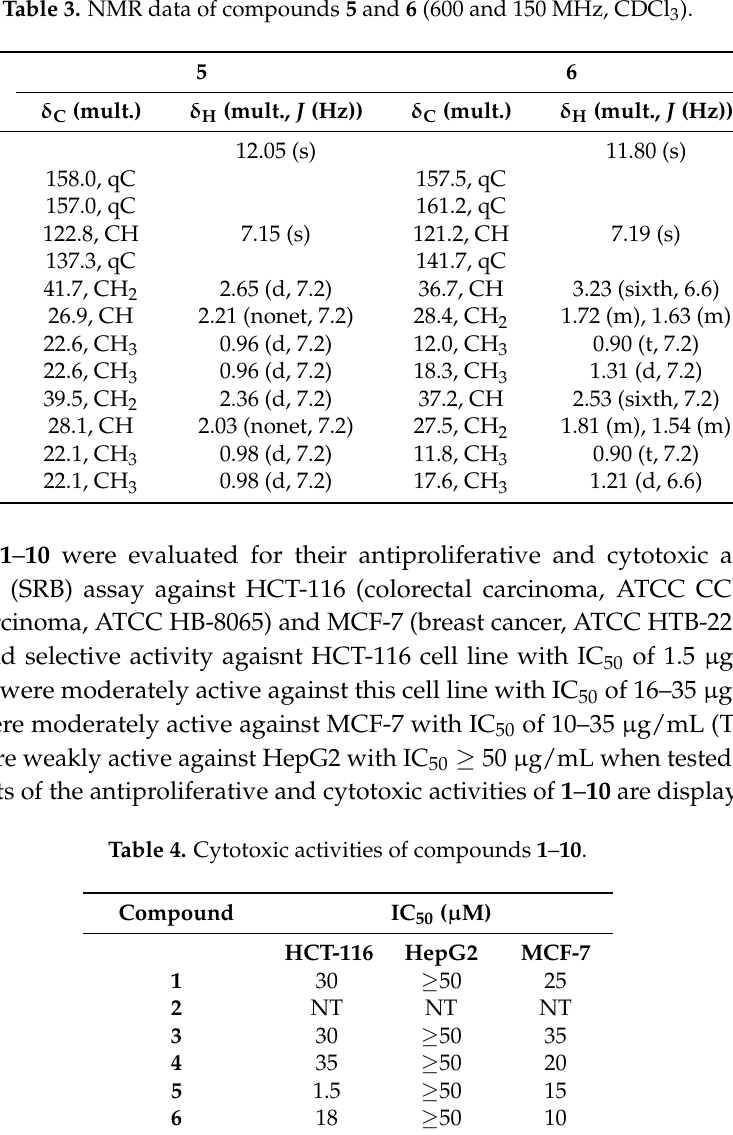
Table 3. NMR data of compounds 5 and 6 (600 and 150 MHz, CDCl 3 ).